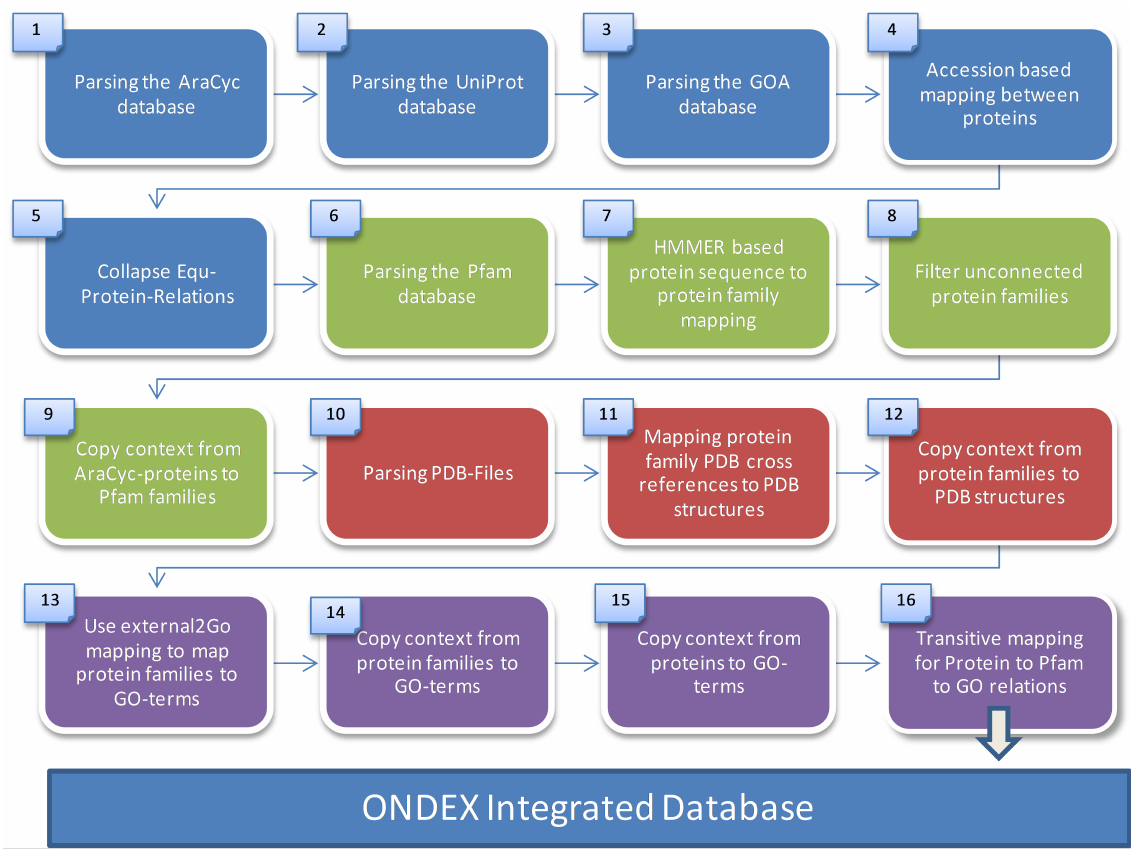
Figure 3: Pipeline for annotating protein sequences with GO terms, protein family information and PDB structures. Blue: Integrating AraCyc, GOA and UniProtKB; Green: Adding PFAM- family information to proteins; Red: Mapping structural information; Purple: Mapping GO terms to proteins.